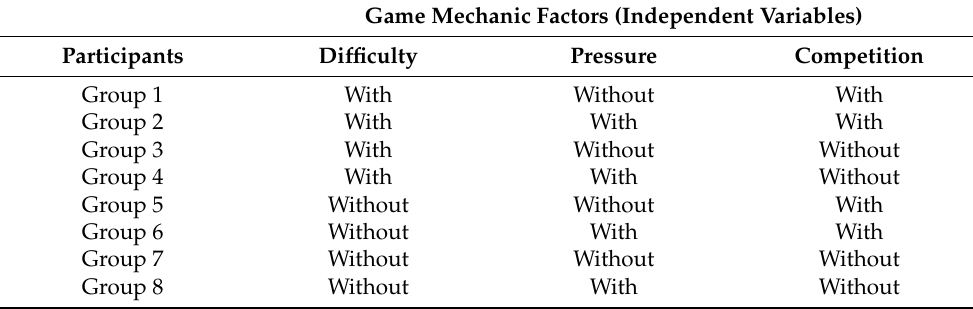
Table 1. Game mechanic factors of the Cleverbrain game in different